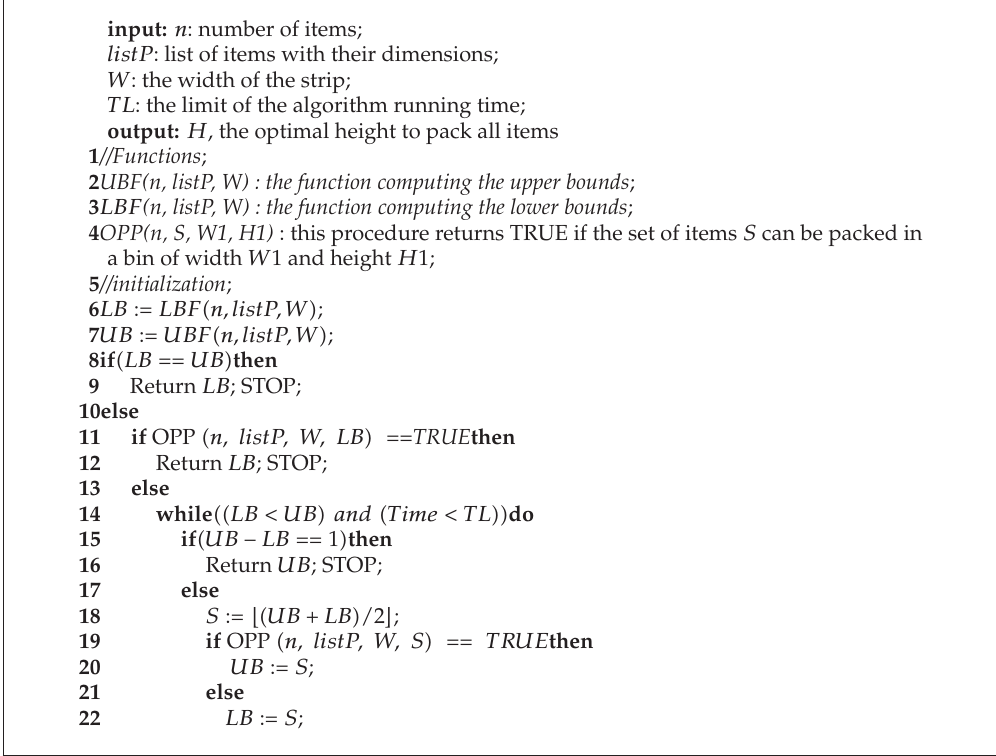
Algorithm 1: Dichotomic Algorithm (cid:2) Bekrar et al. (cid:4) 14 (cid:5)(cid:3)